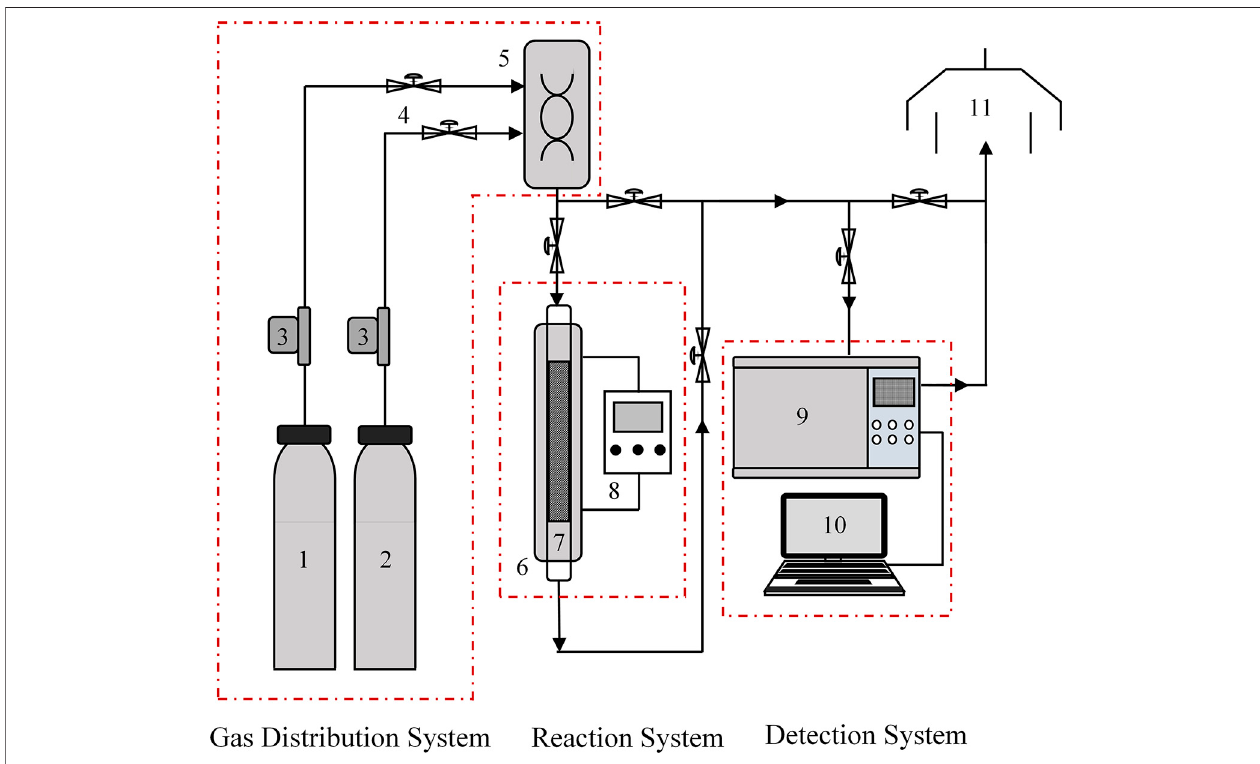
FIGURE1| SchematicoftheCO 2 adsorptionanddesorptionexperimentalsystem:1)N 2 ;2)CO 2 ;3)mass fl owmeters;4)valve;5)mixingtank;6)tubularfurnace;7) adsorber; 8) temperature controller; 9) CO 2 analysis instrument; 10) data recording system; 11) exhaust system.